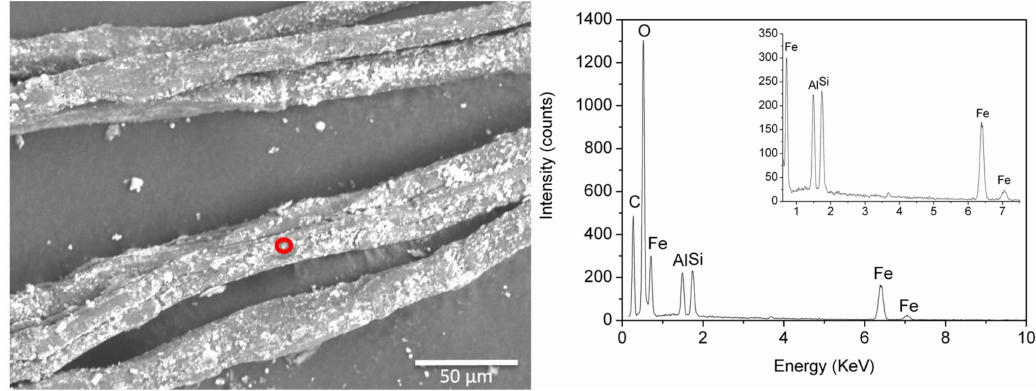
Figure 7. Back scattered electron SEM image of sample ME7 with an EDS spectrum obtained from the bright particles circled in red. Signals from the inorganic components are highlighted in the inset.